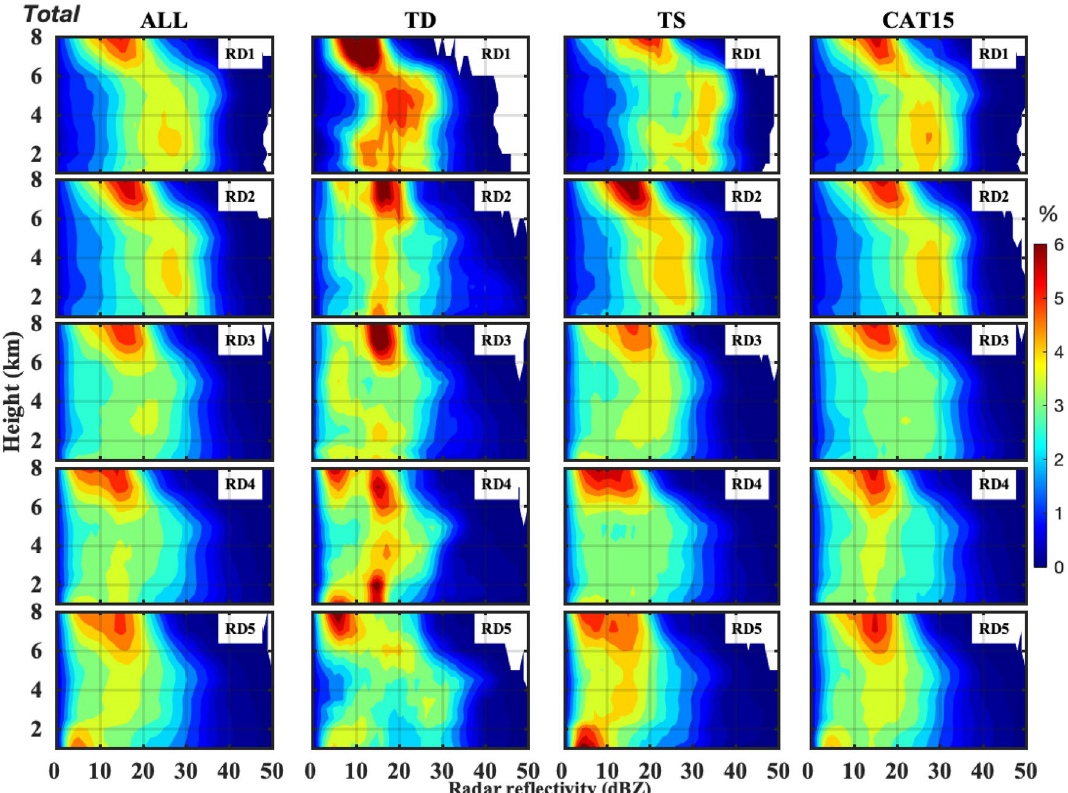
Figure 3. Echo profiles of different category TCs at different radial distances for total precipitation. The contour frequency by altitude diagrams (CFADs) of radar reflectivity for all (first column), TDs (second column), TSs (third column) and CAT15 (fourth column) TCs for different radial distances (RD1: 0–100 km, RD2: 100–200 km, RD3: 200–300 km, RD4: 300–400 km, and RD5: 400–500 shows a gradual downward decrease in the warm rain region of TSs and CAT15 from RD3 to RD5; nonethe- less, for a given region (except RD1), TCs of CAT15 show a higher reflectivity occurrence frequency than TSs. (~ 20–35 dBZ, 12–30 dBZ, 10–25 dBZ, 10–25 dBZ, 5–20 dBZ, for RD1, RD2, RD3, RD4, and RD5, respectively) radially outwards from the TC center. Despite the similar tendency of CAT15 stratiform CFADs to that of the